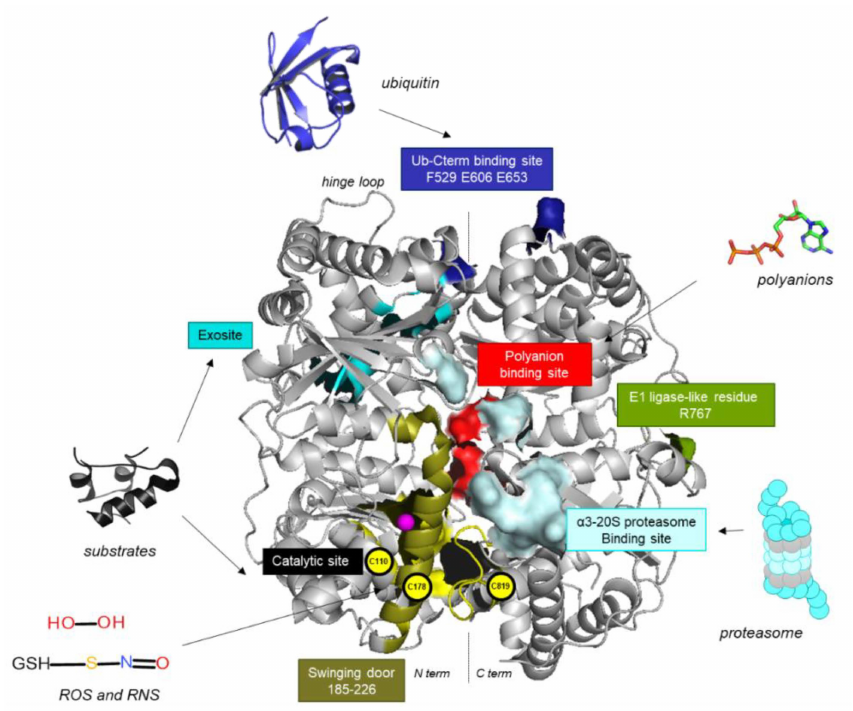
Figure 1. Structure of IDE (from 4NXO). Catalytic site in black; Zn2 + ion in magenta; swinging door in olive exosite in cyan [19]; 20S proteasome binding in light blue [27]; E1 ligase-like activity important residue in green [29]; Ub-C-term binding in marine [28]; polyanion binding site in red [25]; cysteins sensitive to reactive oxygen species (ROS) or reactive nitrogen species (RNS) in yellow spheres [30]. Several important studies have also identified key amino acids for IDE interactions with an α 3-20S proteasome subunit (residues R674; R782; F486; E962; E964) [27] or ubiqui- tine C-term (residues F529 E606 E653)